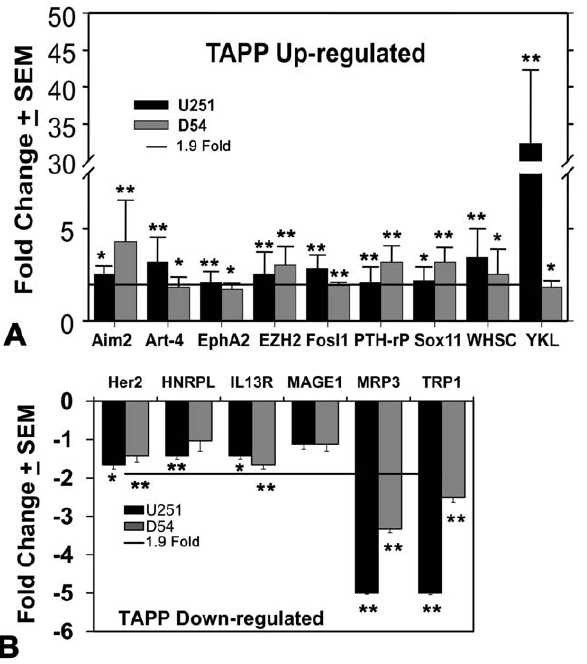
Figure 1. TAPP genes were differentially expressed in glioma cells grown under hypoxic conditions for one week. After one week of culture the hypoxic and normoxic grown cells were harvested, lysed and prepared for qRT-PCR analysis using the glioma tumor antigen panel. The cells grown under hypoxic conditions (1% O 2 ) were directly compared to those simultaneously matched cells grown under normoxic conditions for 1 week. Samples were analyzed 3–6 times depending upon the closeness of the results. Data is represented as fold changes 6 standard error of the means. Panel A shows TAPP genes that were up-regulated in both cell lines; the horizontal line represents the cut-off value (1.9-fold increase) that we believe represents a biologically significant value. Panel B shows the genes down-regulated in both glioma cells. The horizontal line in this panel represents a $2 1.9- fold reduction value which we believe represents a threshold of biological significance. The data for the other TAPPs, which did not show any significant change, and is not presented for the sake of brevity. The single asterisk signifies P , 0.05, while double asterisk shows P , 0.01 value between the data generated from the normoxic and hypoxic cells.